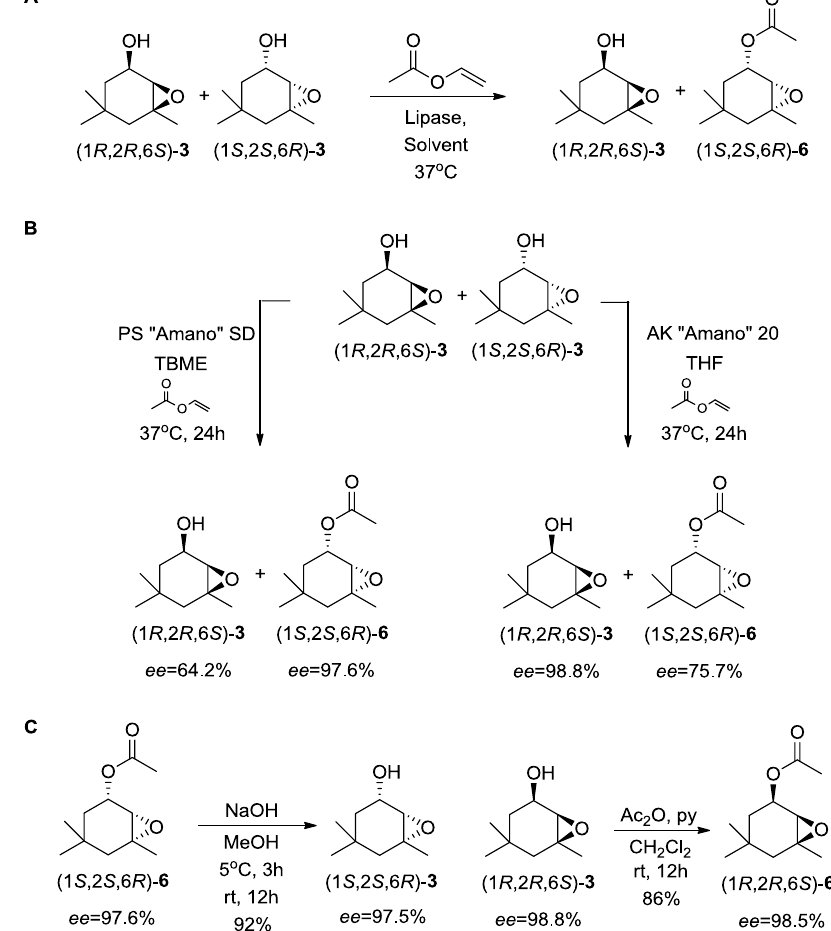
Figure 6. Enantioselective synthesis of cis - 3 and cis - 6 by biocatalytic approach. ( A ) Optimization of best conditions for kinetic resolution of cis - 3 were performed with five different lipases (CAL-B, PS “Amano” SD, AK “Amano” 20, AY “Amano” 30, and PPL) and three organic solvents (TBME, THF, and hexane). ( B ) The best conditions found in A were employed to synthesize (1 R ,2 R ,6 S )- 3 , and (1 S ,2 S ,6 R )- 6 with good enantiomeric excesses. ( C ) Synthesis of (1 S ,2 S ,6 R )- 3 and (1 R ,2 R ,6 S )- 6 by basic hydrolysis and acetylation,